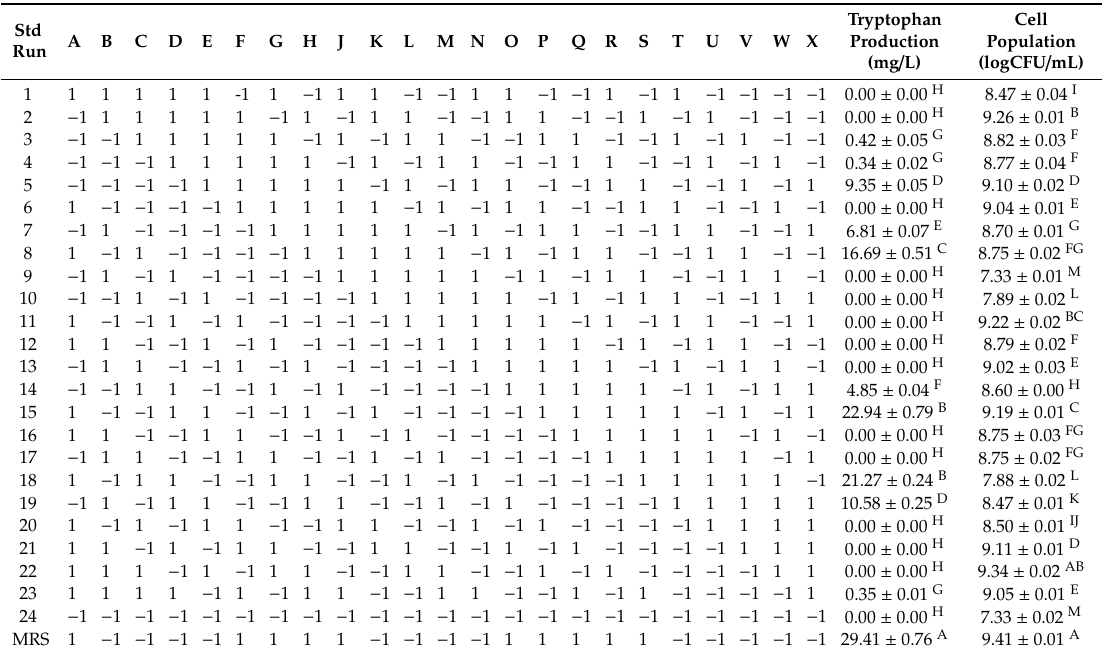
Table 1. Plackett-Burman Design (PBD) matrixes for 22 variables with coded values and their corresponding tryptophan production and cell population of P. acidilactici